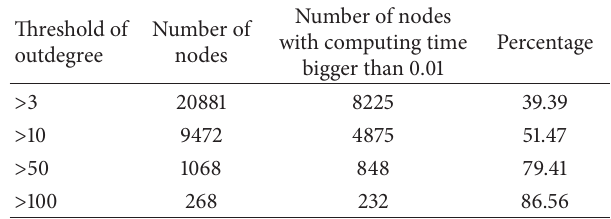
Table 3: Threshold of outdegree and computing time of edu04